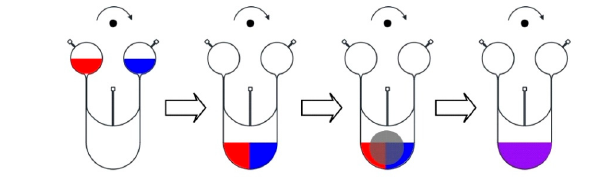
Figure 2. Operational principles of the chaotic mixing system. The two different colors represent two fluid samples that are introduced into the mixing chamber first. The dark circle in the 3rd figure indicates the pin pressing against the covering membrane of the mixing chamber.